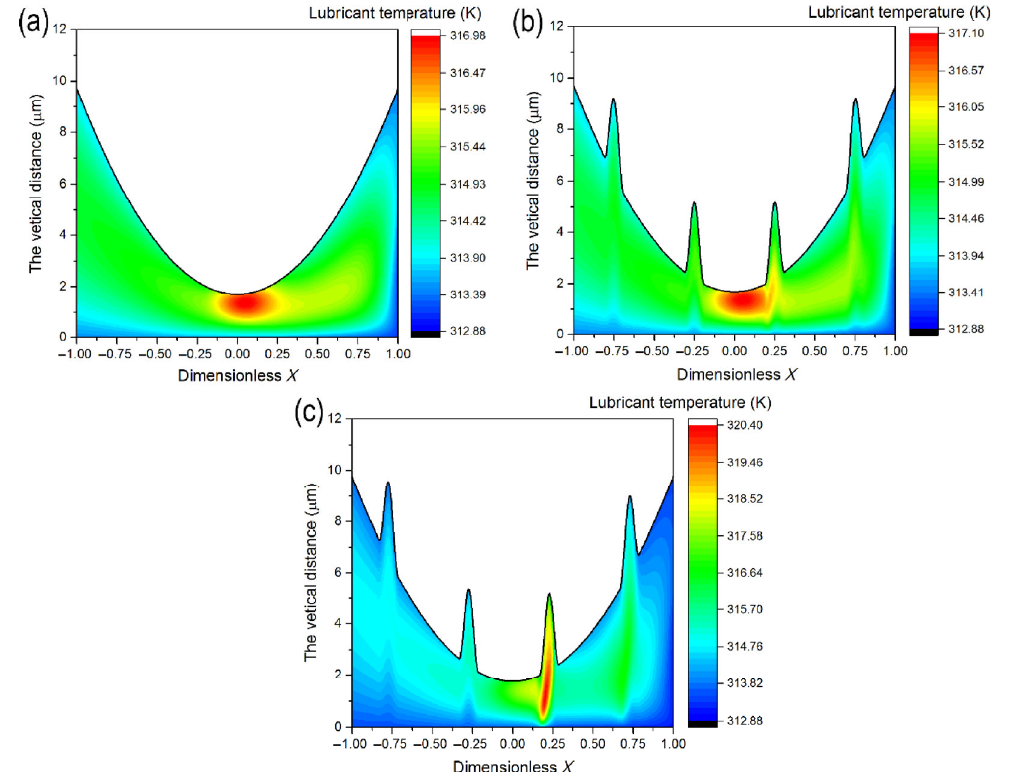
Fig. 6 The temperature distribution in oil film between the coated ring and the liner under the cold engine condition when the crank angle is 380 degree and the coating’s elasticity modulus is 62.5 GPa: (a) for the smooth conjunction; (b) for the textured ring conjunction; (c) for the textured liner